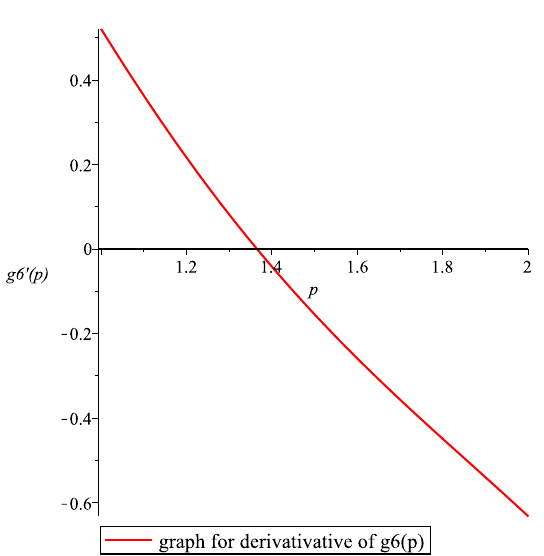
Figure 1. Graph for g 6 ( p ) .